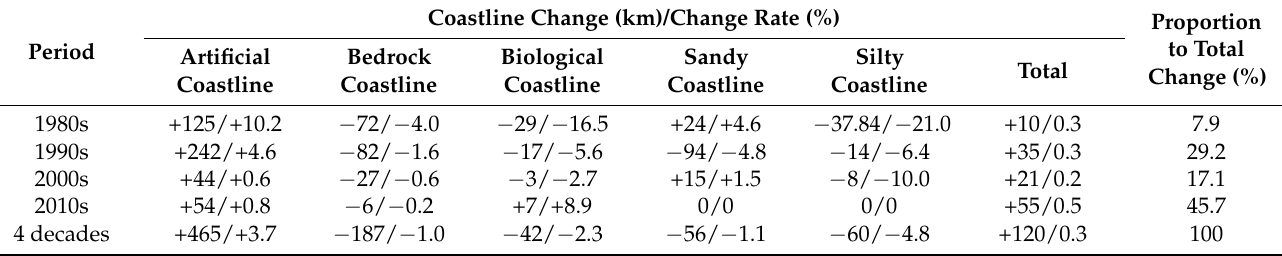
Figure 5. Coastline length in the GHMGBA at different times. Table 2. Variation of coastline in the GHMGBA in different decades.